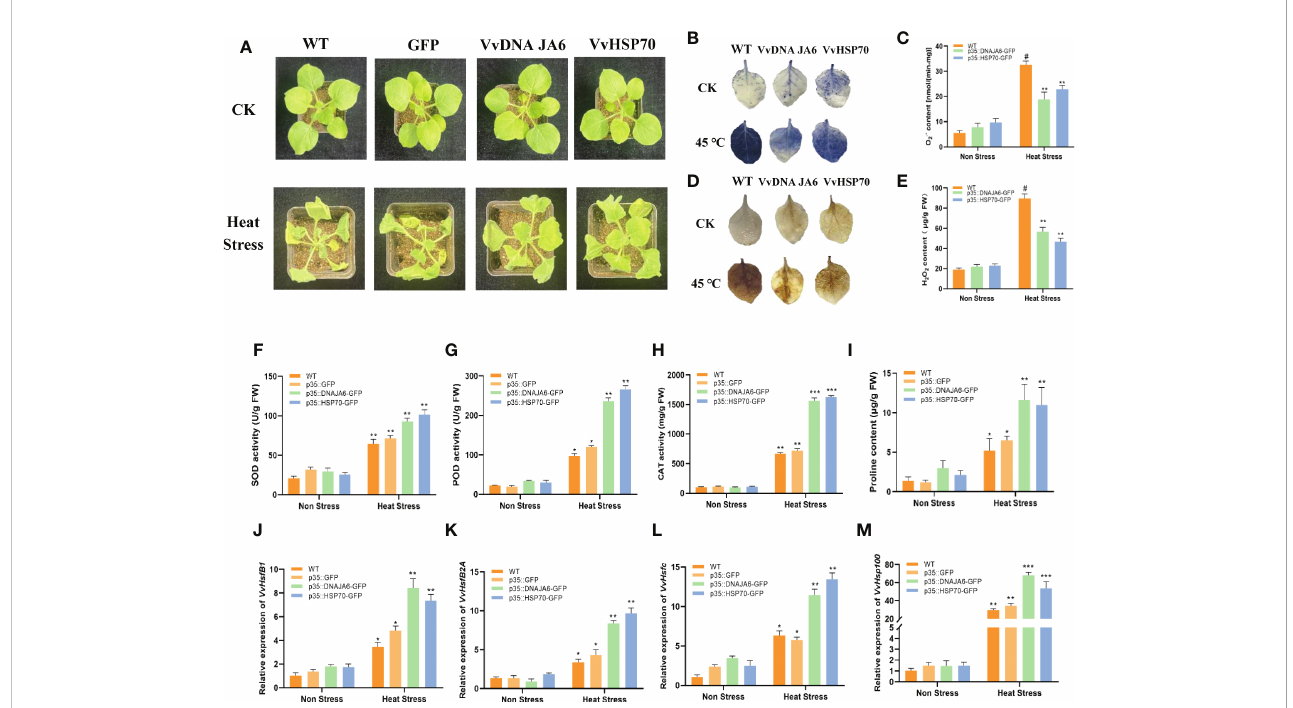
FIGURE 7 DNA JA6 and HSP70 play a positive role in response to heat stress. (A) The phenotype of WT, DNA JA6 and HSP70 transient over expression in tobacco after heat stress. The observation of NBT staining (B) and the test of O 2 (cid:129) - content (C) . The observation of DAB staining (D) and the test of H 2 O 2 content (E) . Analysis of physiological indexes SOD activity (F) , POD activity (G) , CAT activity (H) and proline content (I) in WT, GFP , DNA JA6 and HSP70 transient over expression tobacco after heat stress. Relative expression of heat stress marker gene VvHsfB1 (J) , VvHsfB2A (K) , VvHsfc (L) and VvHSP100 (M) in transient over expression tobacco after heat stress. The results perform the mean ± SE of three independent replicates ( P < 0.05). “ # ” represent the object being compared. “ * ” represent difference. "**" represent signi fi cant difference. “ *** ” represent extremely signi fi cant